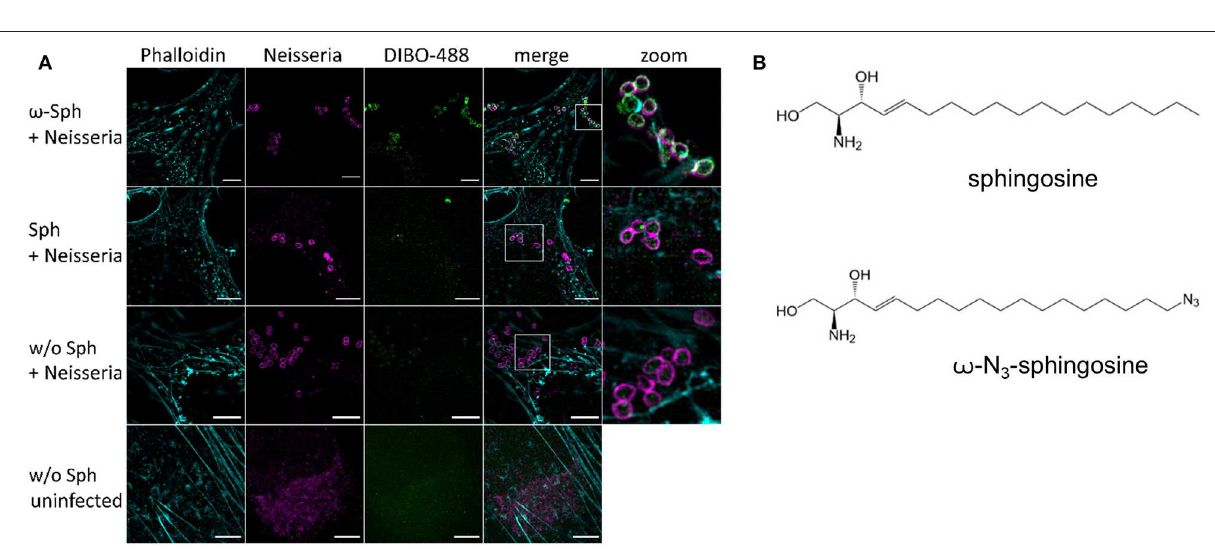
FIGURE 5 | Incorporation and equal distribution of ř -azido-sphingosine into neisserial membrane of N927. (A) Chang cells were fed either with clickable sphingosine-analog (10 µ M ř -N 3 -sphingosine, ř -Sph) or sphingosine (10 µ M, Sph). These cells were infected for 4h and then the clicking reaction with dye DIBO-488 was performed. Cells were stained for actin (Phalloidin) and immunolabeled for Neisseria . (B) Chemical structures of native sphingosine and the clickable derivate ř -N 3 -sphingosine. Images represent a minimum of eight fields viewed per replicate of three independent experiments. Bars 5 µ m.